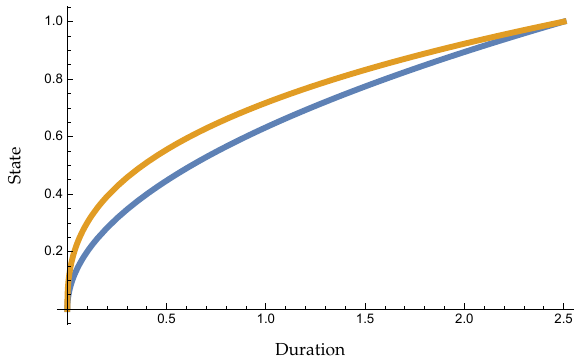
Figure 13. Strategy OPT (Blue) and online strategies for t = 0.712, z = 0.1